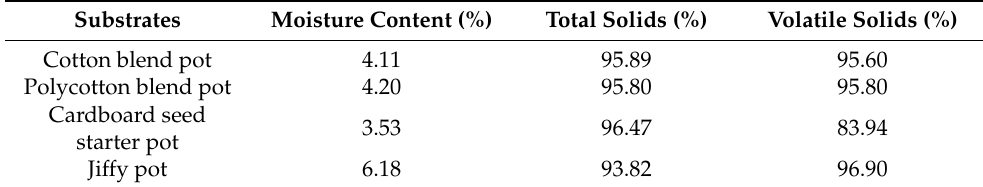
Table 2. Solids analysis of seedling pots used for anaerobic digestion.